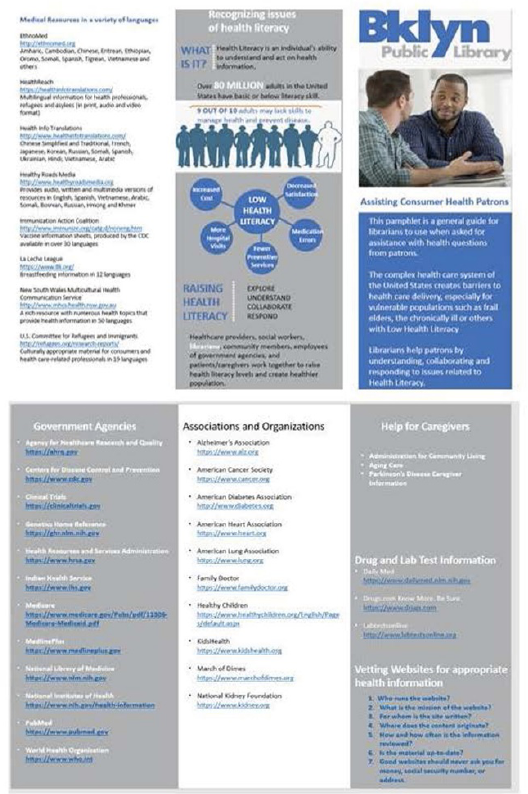
Figure 2 Brooklyn Public Library tri-fold